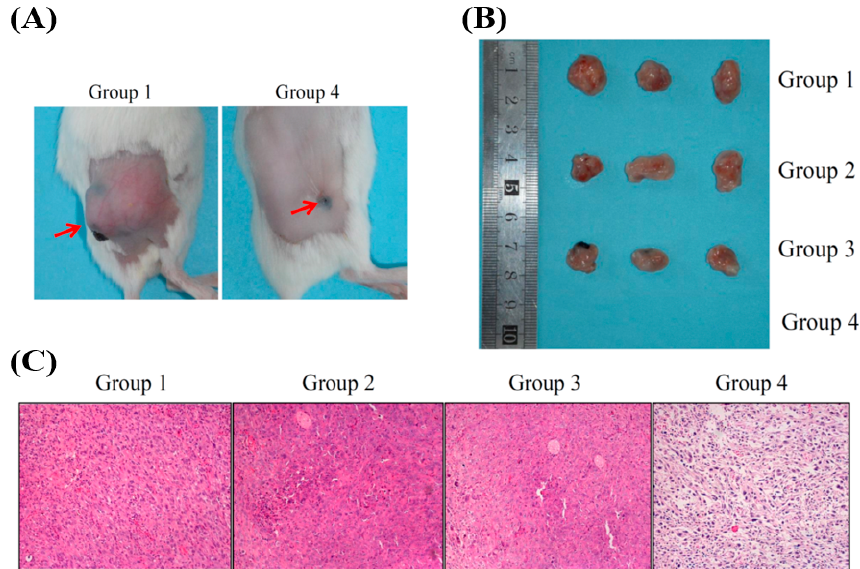
Figure 6. ( A ) Photographs of mice bearing 4T1 tumours 17 days after treatments. ( B ) Photographs showing the tumours from mice 17 days after intratumor injection of PBS and FeOxH–rGO, with or without NIR irradiation. ( C ) Haematoxylin and eosin staining of the tumour-tissue section after intratumor injection of PBS and FeOxH–rGO, with or without NIR irradiation. Group 1: PBS; Group 2: PBS + NIR laser; Group 3: FeOxH–rGO; Group 4: FeOxH–rGO + NIR laser. The condition of NIR laser irradiation was the same with Figure 5.